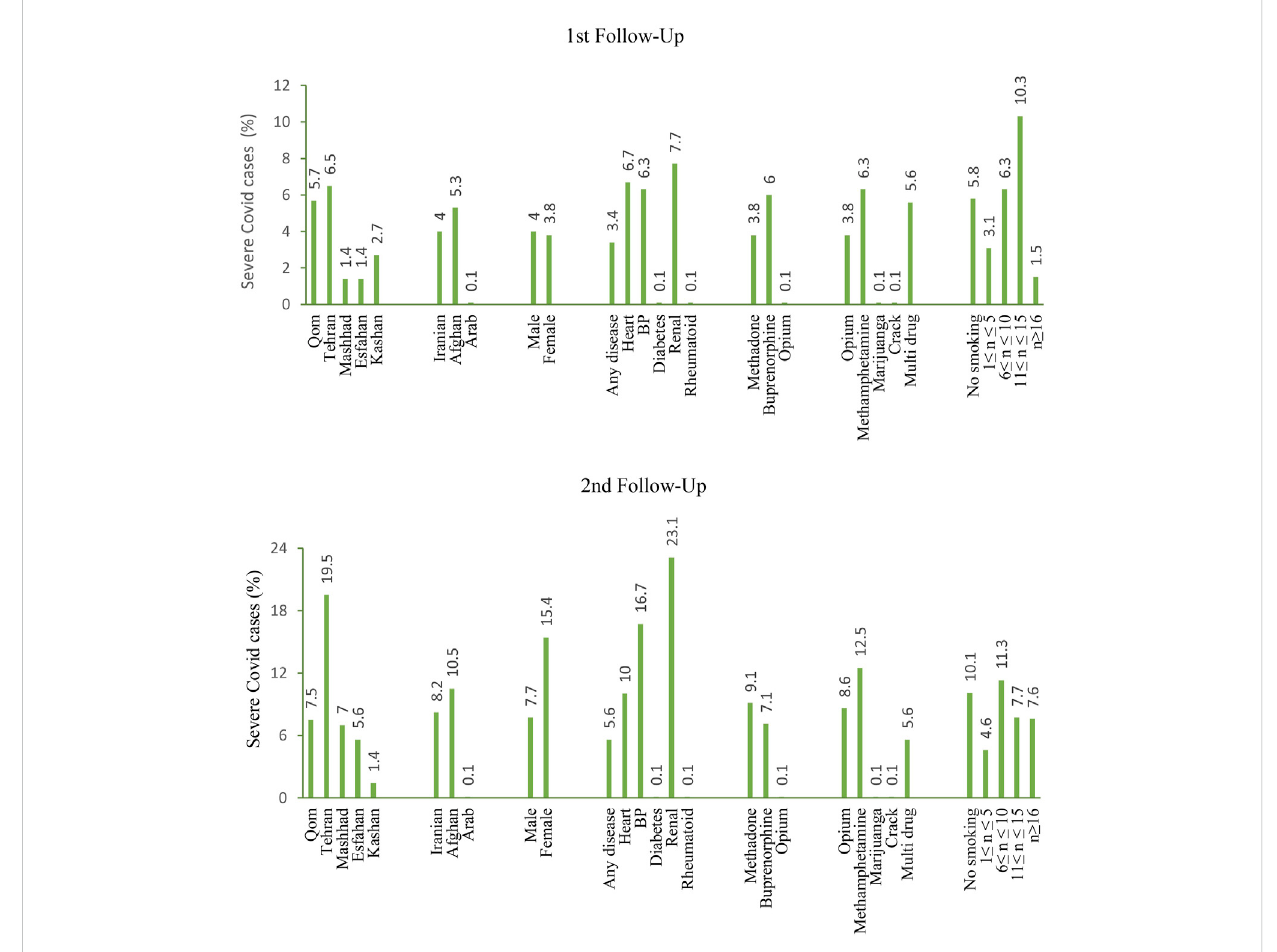
FIGURE 3 Percentage of patients with severe COVID-19 ( ≥ 4 symptoms) referred to MMT centers in the fi rst and second